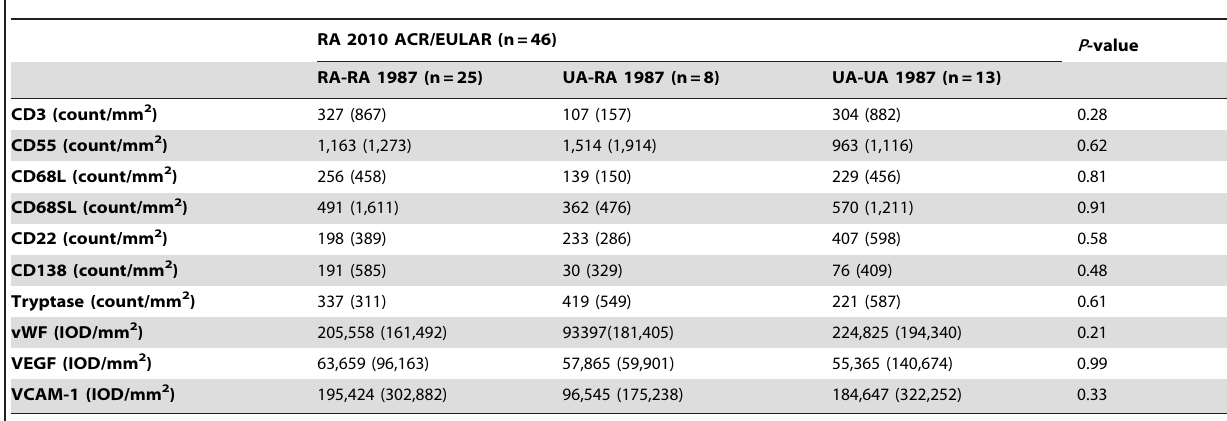
Table 3. Expression of synovial phenotypic and vascular markers in patients who fulfilled 2010 ACR/EULAR criteria for RA at baseline subclassified according to fulfillment of 1987 ACR criteria at baseline and after follow